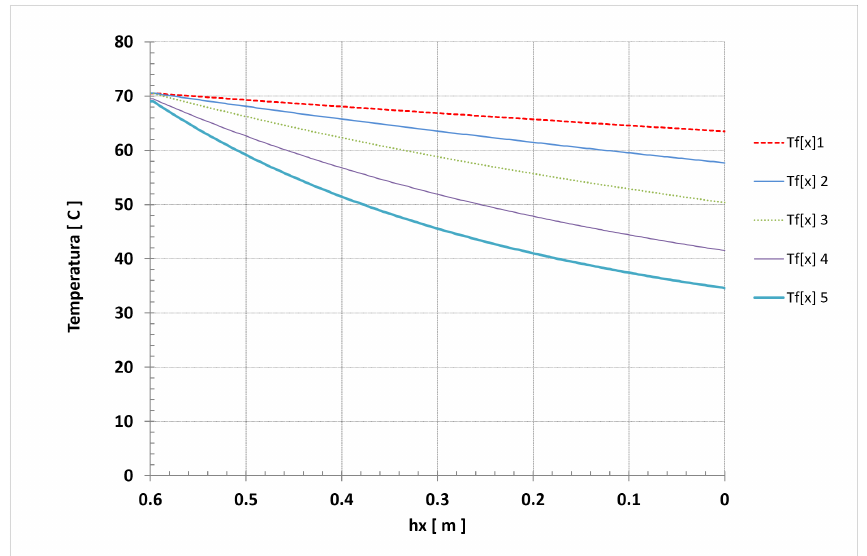
Figure 13. Profile of the radiator surface temperature temperature change, radiator T1. t s = 70.2 ◦ C, qmx from 39% to 356% qmo ( nominal flow rate